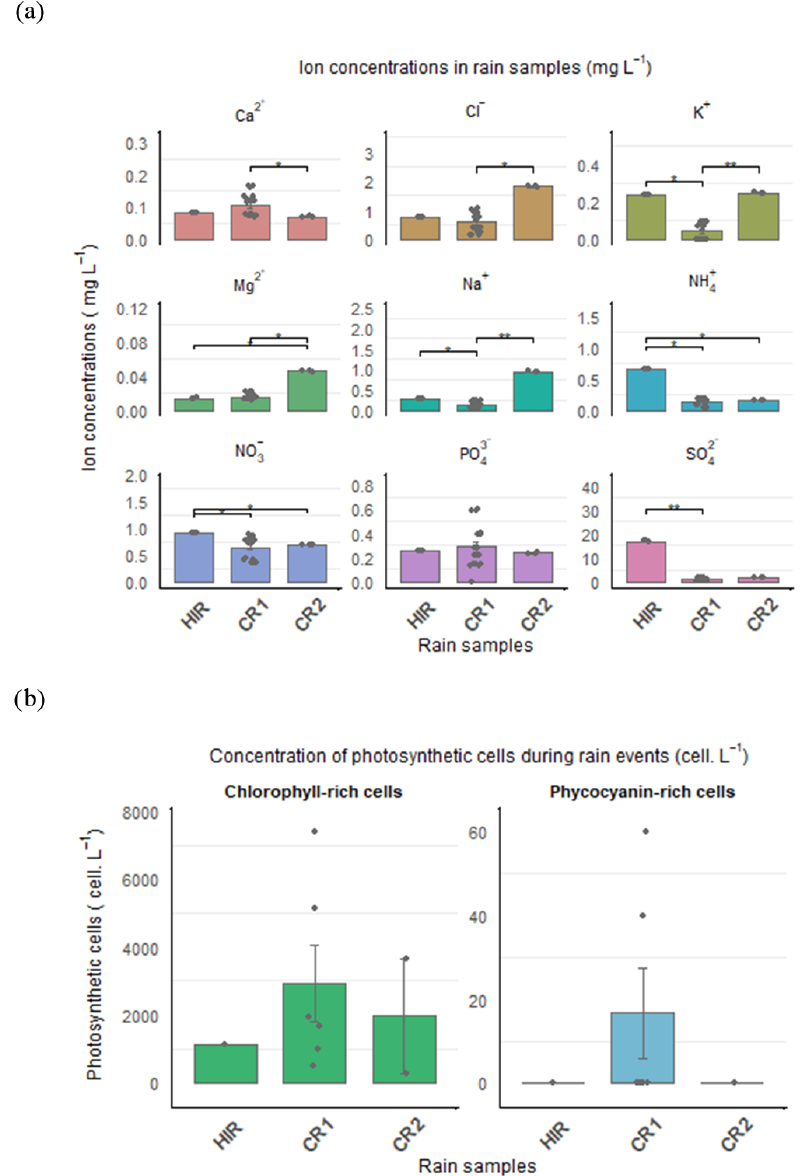
Figure 5. (a) Inorganic anion and cation concentrations (mgL − 1 ) and (b) photosynthetic cell concentrations (cells L − 1 ) in HIR, CR1, and CR2. The significance level from the Dunn test is shown to compare the nutrient concentration between rain